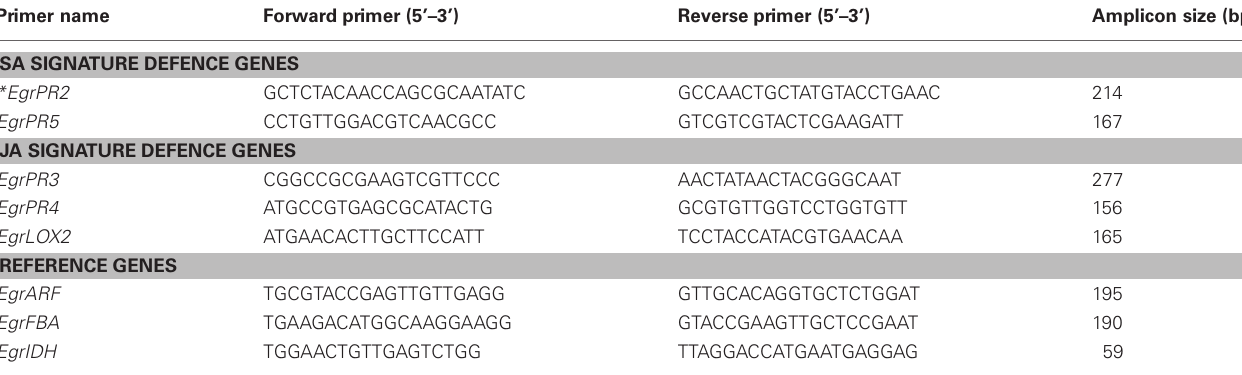
Table 1 | Primer sequence of Eucalyptus target signature defence genes and reference genes assessed using